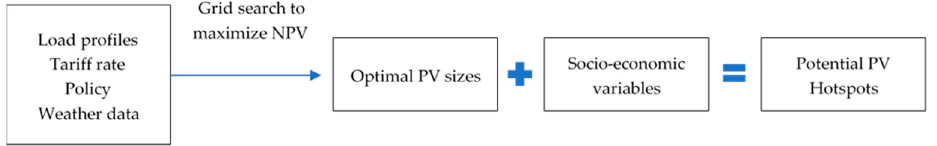
Figure 2. Summary of the hotspot selection procedure.